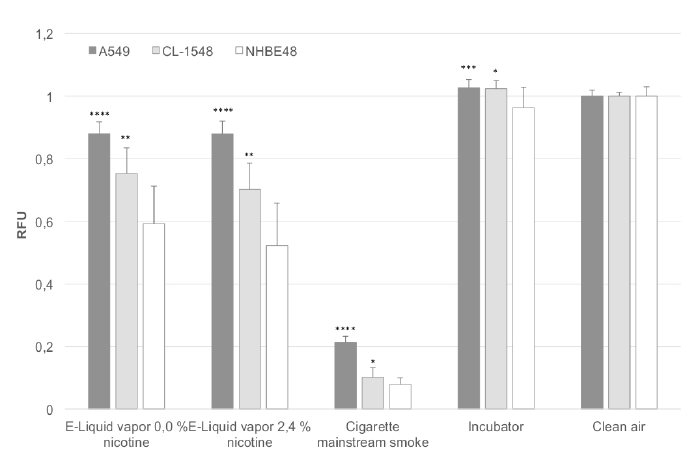
Figure 1. Puff-adjusted values for cell viability after exposure. The results are normalized to the clean air control and are given as a mean of five (NHBE48) and three (CL-1548, A549) independent experiments with three samples each + standard deviation. The asterisks indicate the statistical significance compared to NHBE48 cells. The relevance of the significance is explained in Section 2.6.